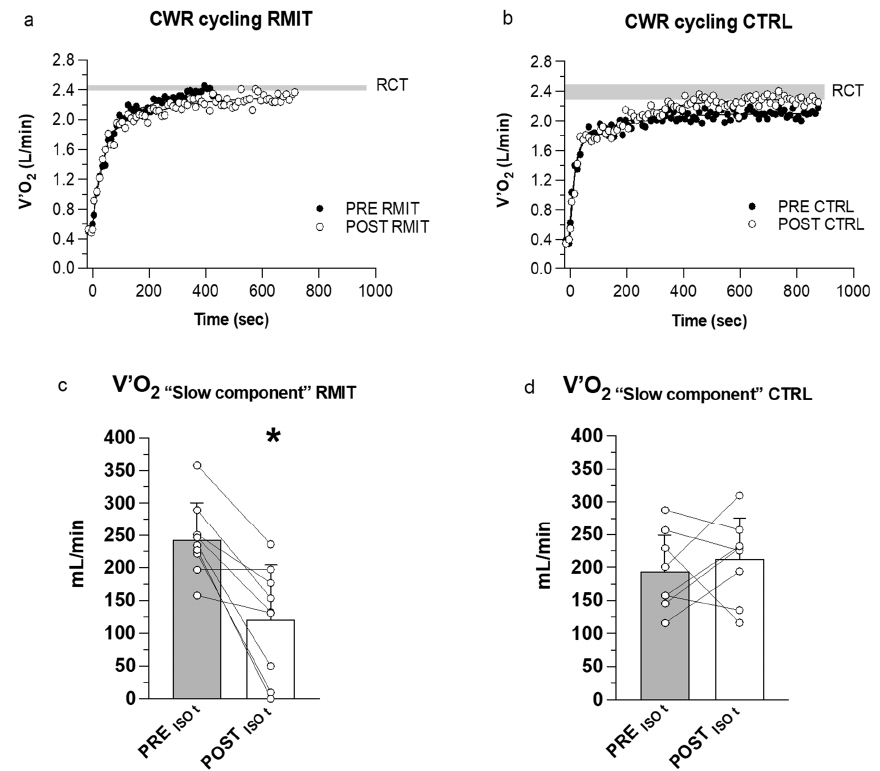
. VO 2 as a function of time during CWR>GET carried